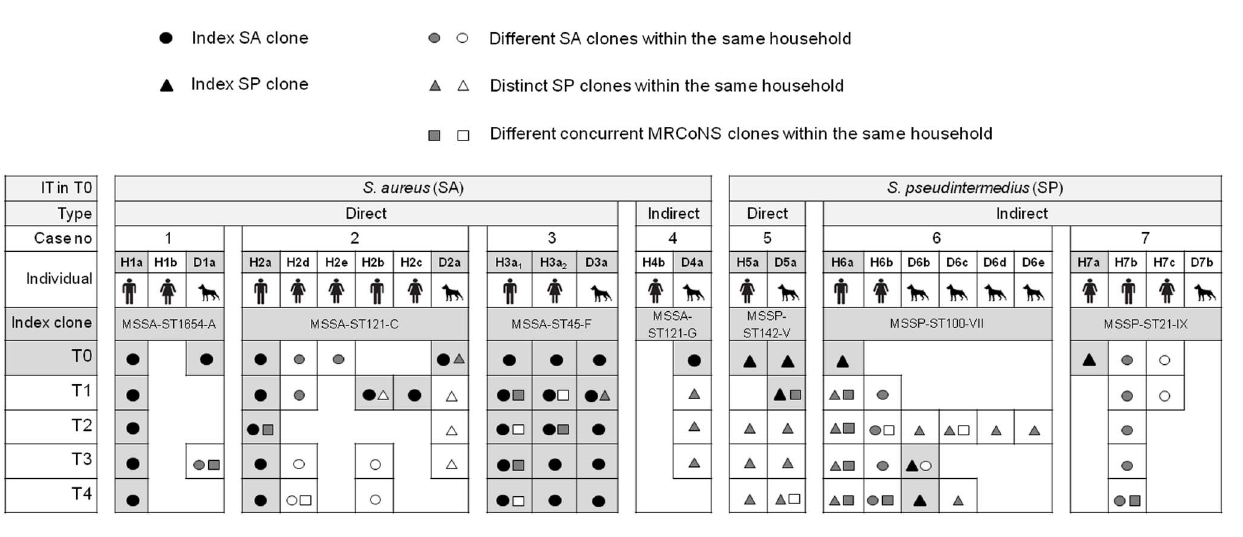
Figure 1. Schematic representation of the dynamics of carriage of the seven households investigated. MRCoNS, methicillin-resistant coagulase negative staphylococci. IT, bacterial species responsible for interspecies transmission. Type, type of interspecies transmission (Direct, Indirect). Case no, number of the households investigated in this study. Individuals are named H (for human) or D (dog) followed by the case number (1 to 7) and a lower-case letter to differentiate subjects per household; if necessary, a lower script number was added. Nomenclature of individuals involved in index cases (T0) is displayed with gray background. T0 to T4, the different samplings. Index clone, S. aureus or S. pseudintermedius clones responsible for interspecies transmission in index cases